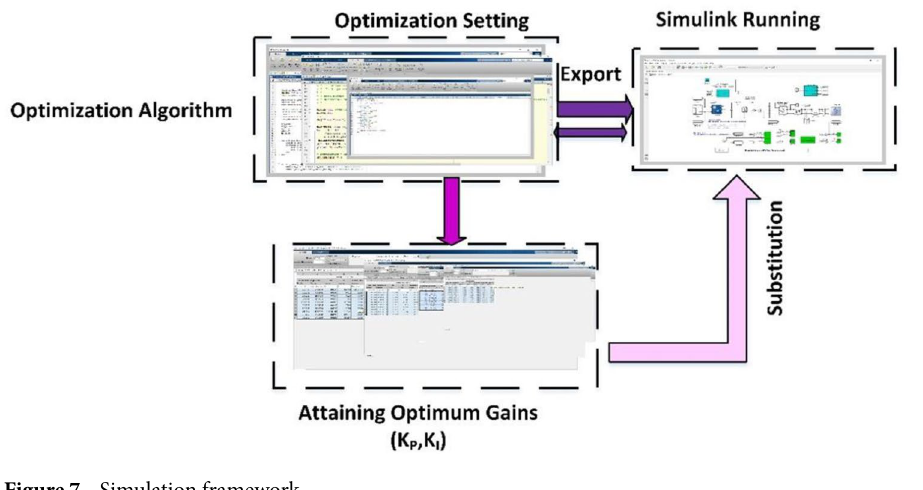
Figure 7. Simulation framework.